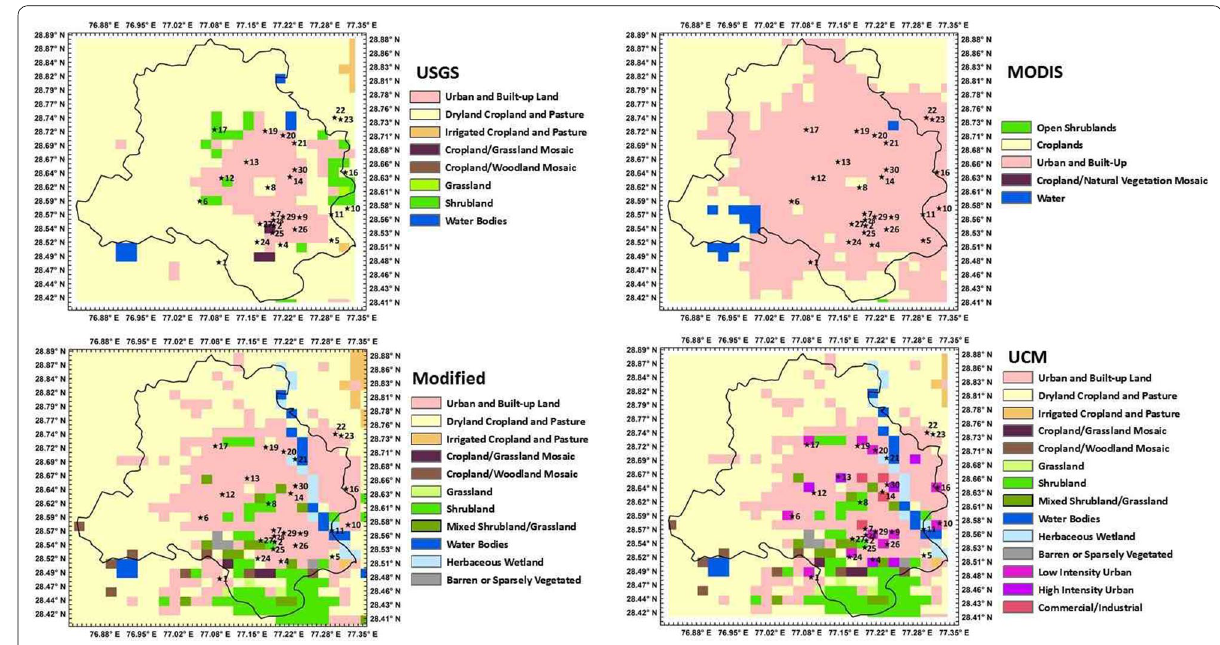
Fig. 2 Representation of different land use/land cover in four model simulations